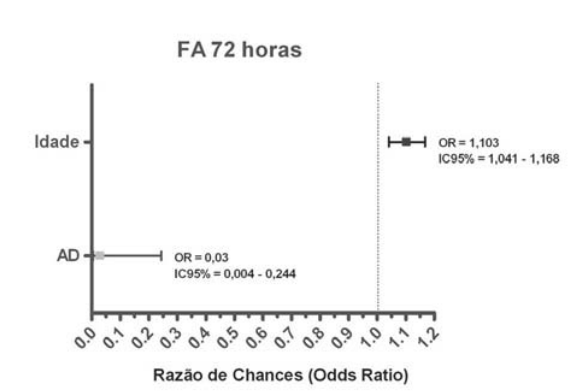
Fig. 2 - Fatores de risco e a razão de chances (odds ratio) para o aparecimento de FA durante o período de 72 horas